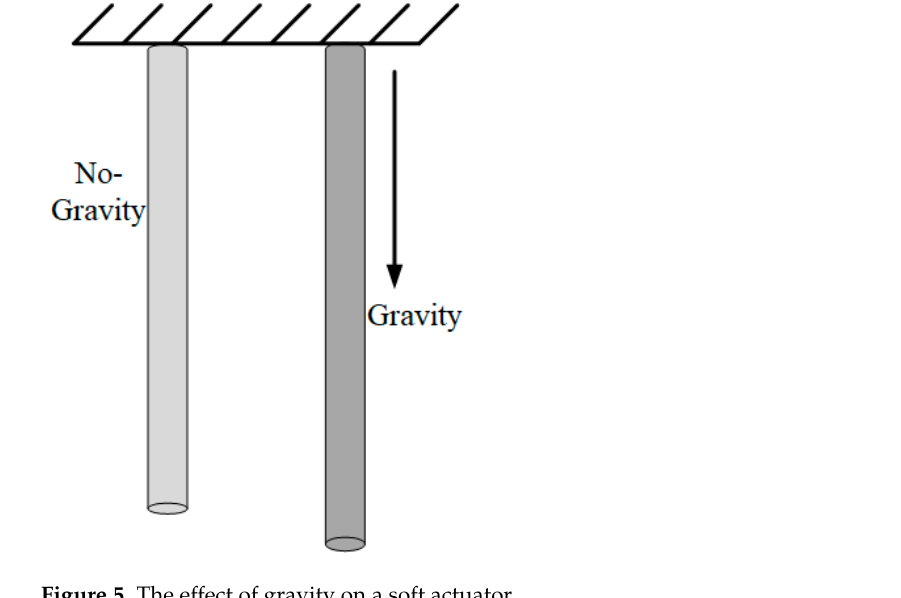
Figure 5. The effect of gravity on a soft actuator.